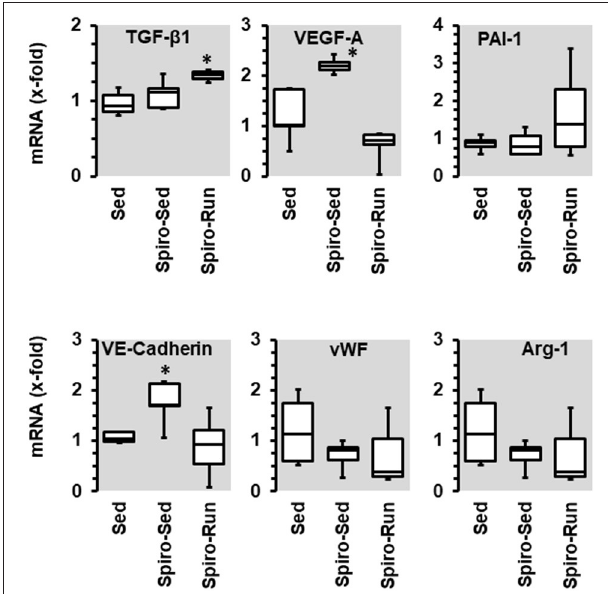
FIGURE 9 | Effect of 10 months voluntary running wheel activity (Run) and spironolactone (Spiro) on mRNA expression of selected proteins in hypertensive rats compared to sedentary controls (Sed). Box plots represent 25, 50, and 75 percentiles with 5 and 95 percentiles given as whiskers. * p < 0.05; One-Way ANOVA with subsequent Student-Newman-Keuls post-hoc analysis.